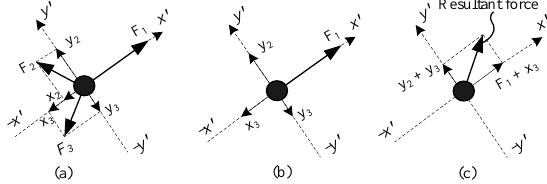
Figure 2. Calculating Resultant force: (a) Establish a local coordinate using direction of the maximal force (F 1 ) as as the x’ axis direction, and resolve each individual force along the local coordinate axes ( x’, -x’, y’,-y’ ), (b) Select the largest components, (F 1 , x 3 , y 2 , y 3 ), in each of the four main directions, and (c) Calculate the resultant